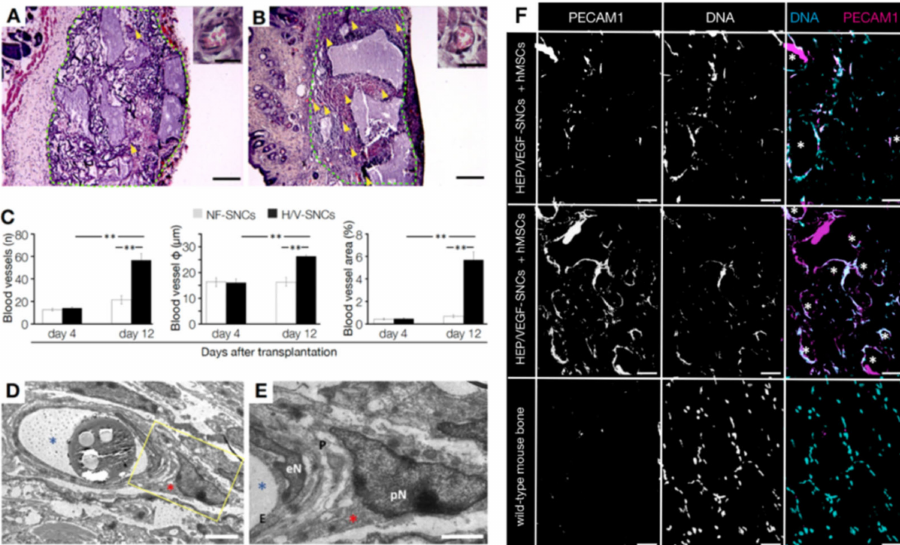
Figure 3. Vasculoneogenesis in bone substitutes subcutaneously implanted in nude mice. ( A , B ) H&E staining of bone substitutes (green lines) with either empty (NF-) ( A ) or HEP/VEGF- ( B ) SNCs, at 12 dpi. Yellow arrowheads indicate blood vessels. Scale bars: 200 µ m. The images at the top right show enlargements of blood vessels. Scale bars: 20 µ m. ( C ) Quantitative analysis of the vessels found in the implanted bone substitutes. The average number and diameter of the vessels found, together with the average surface covered are given at 4 and 12 dpi. Values are expressed as mean ± SD of at least five images/section and four sections/sample. **: p ≤ 0.05. ( D , E ) Ultrastructural view of a blood vessel found in the HEP/VEGF-SNCs bone substitute, shown as a transverse section. Mural cells enveloping the blood vessels (e.g., the pericyte indicated with a red asterisk) were found in the nano-active bone substitute. ( E ) This is the enlargement of the area delimited by the yellow frame in ( D ). No blood cells are in the lumen of the vessel, as a contrast agent was perfused (residues indicated with a blue asterisk). E: endothelial cell; eN: nucleus of the endothelial cell; P: pericyte; pN: nucleus of the pericyte. Scale bars: 5 µ m in d, 2 µ m in e. ( F ) Endothelial cells of human origin in the bone substitute, as revealed with anti-human (top panels) or anti-human/mouse PECAM1 antibody (mid panel). Mouse control bone was negative to the anti-human PECAM1 antibody (lower panel). Scale bars: 200 µ